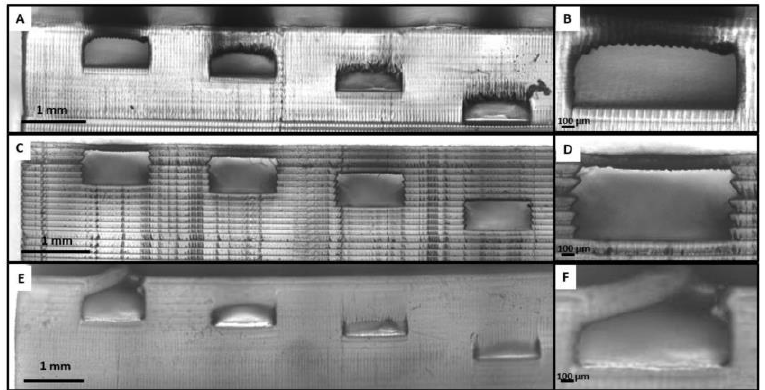
Figure 6. Images of the DLP 3D printed devices by Subirada et al. [99] using Detax ( A , B ), Asiga ( C , D ), and Keyprint ( E , F ) resins. ( C , D ), and Keyprint ( E , F )